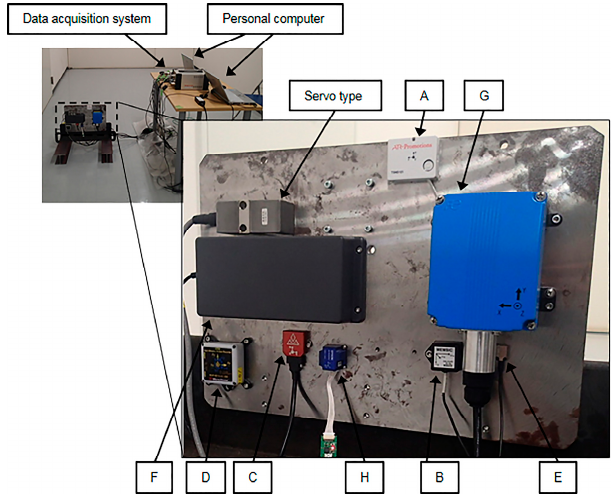
Figure 3. Test setup for analyzing static characteristics of accelerometers listed in Table 2.